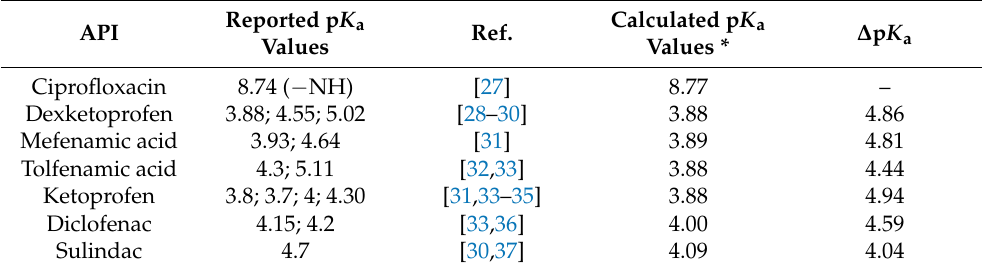
Table 1. Molecules used to make salts with CIP and their corresponding p K a values. API